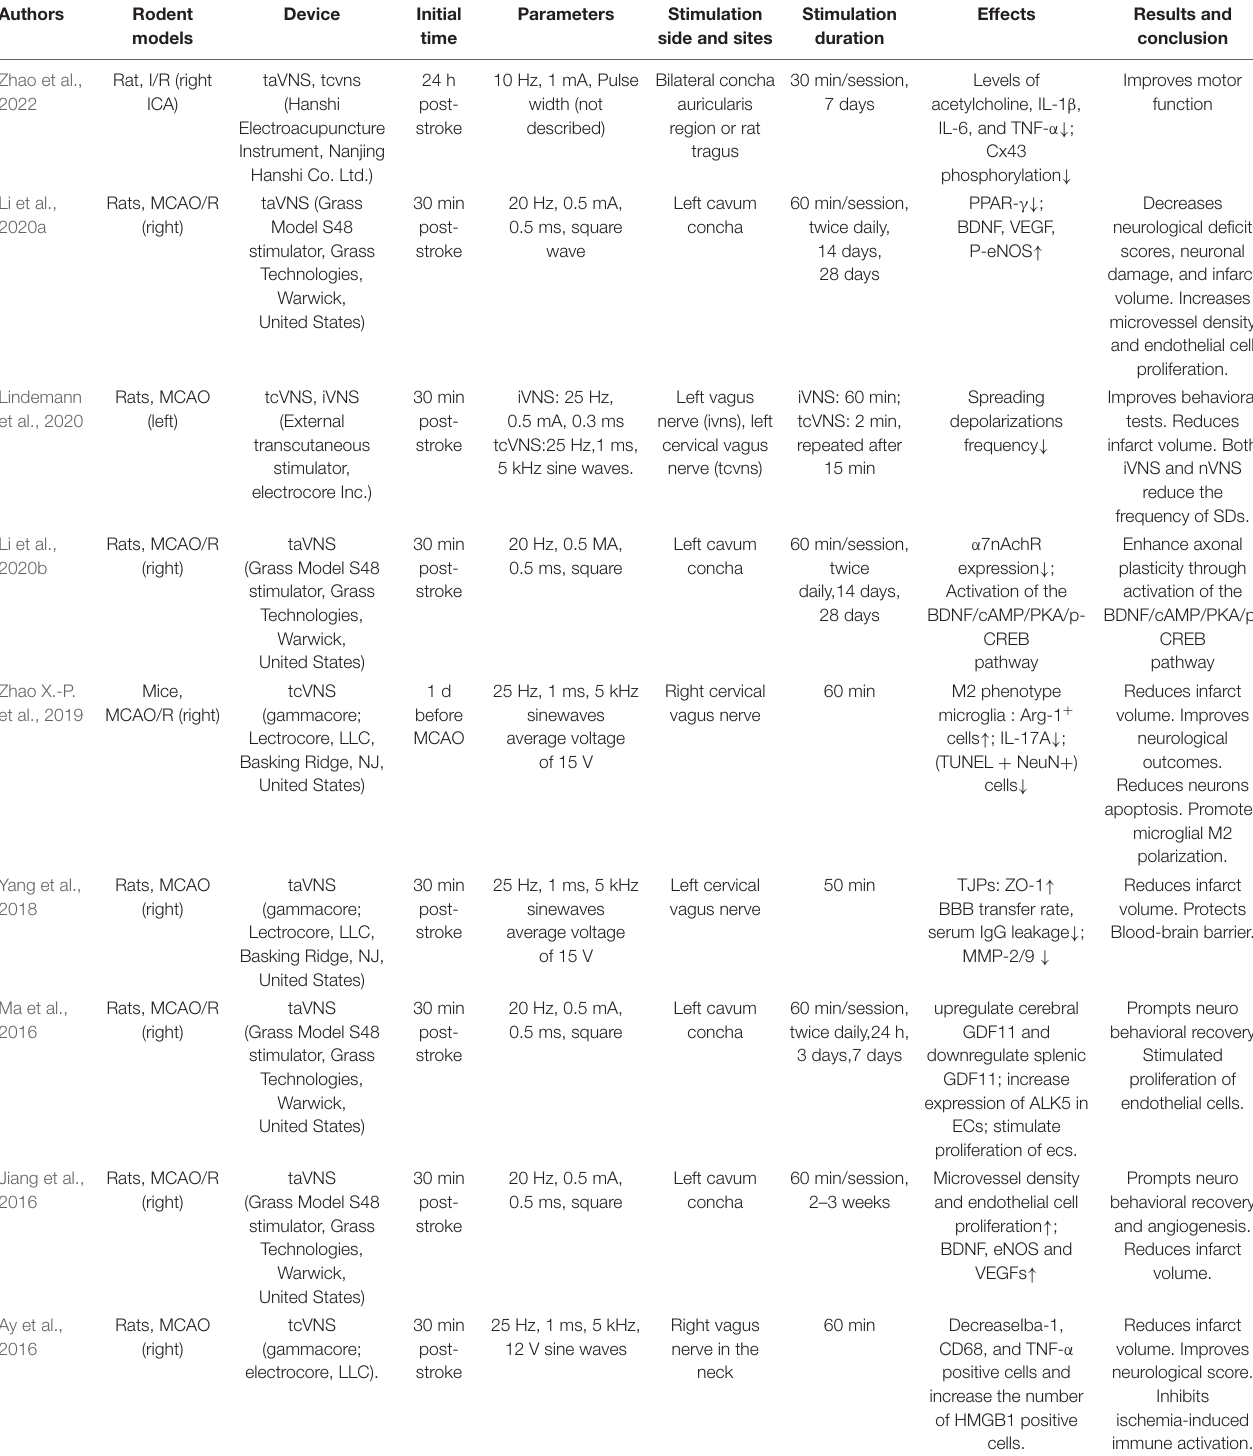
TABLE 2 | Stimulation location, parameters, and therapeutic effects for all studies of nVNS in rodent models of